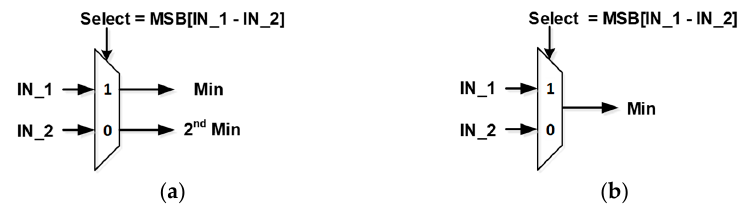
Figure 4. ( a ) 2-to-2 comparator and ( b ) 2-to-1 comparator.